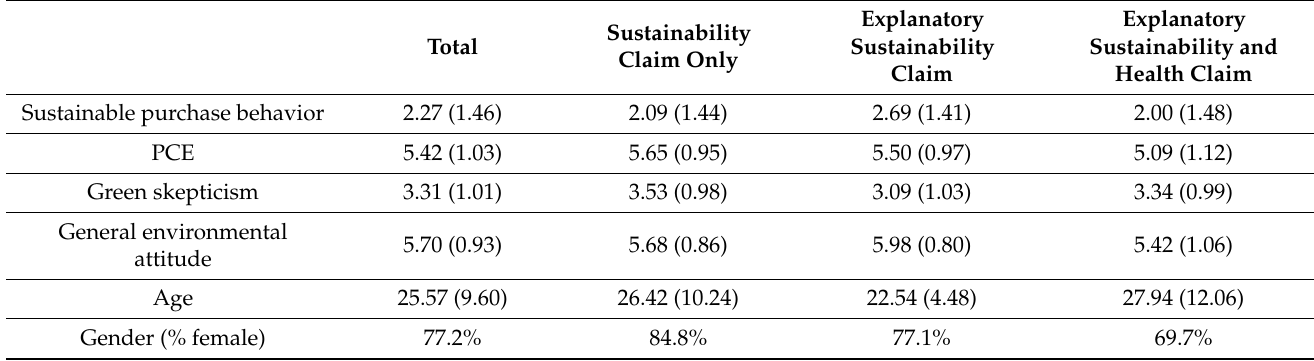
Table 1. Descriptives of the total sample and divided by condition.